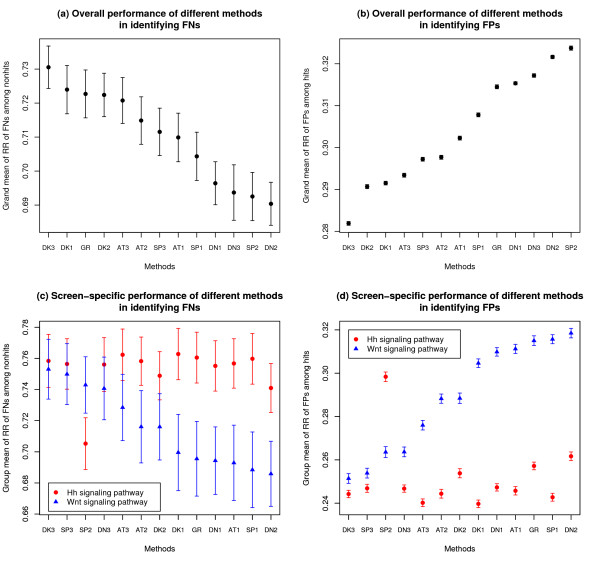
The overall performance of different methods in identifying FNs (a) and FPs (b) in the rank-based test and the screen-specific performance of different methods in identifying FNs (c) and FPs (d) in the rank-based test. The error bars represent the estimated standard deviations for the corresponding quantities. The DN, SP, DK and AT represent the four different network similarity measurements, i.e., direct neighbor, shortest path, diffusion kernel and association analysis-based transformation, respectively. Index 1, 2 and 3 represent the three different summarizing formulas, respectively (see Additional file 1 – Table S2 for details). GR represents the GeneRank algorithm.